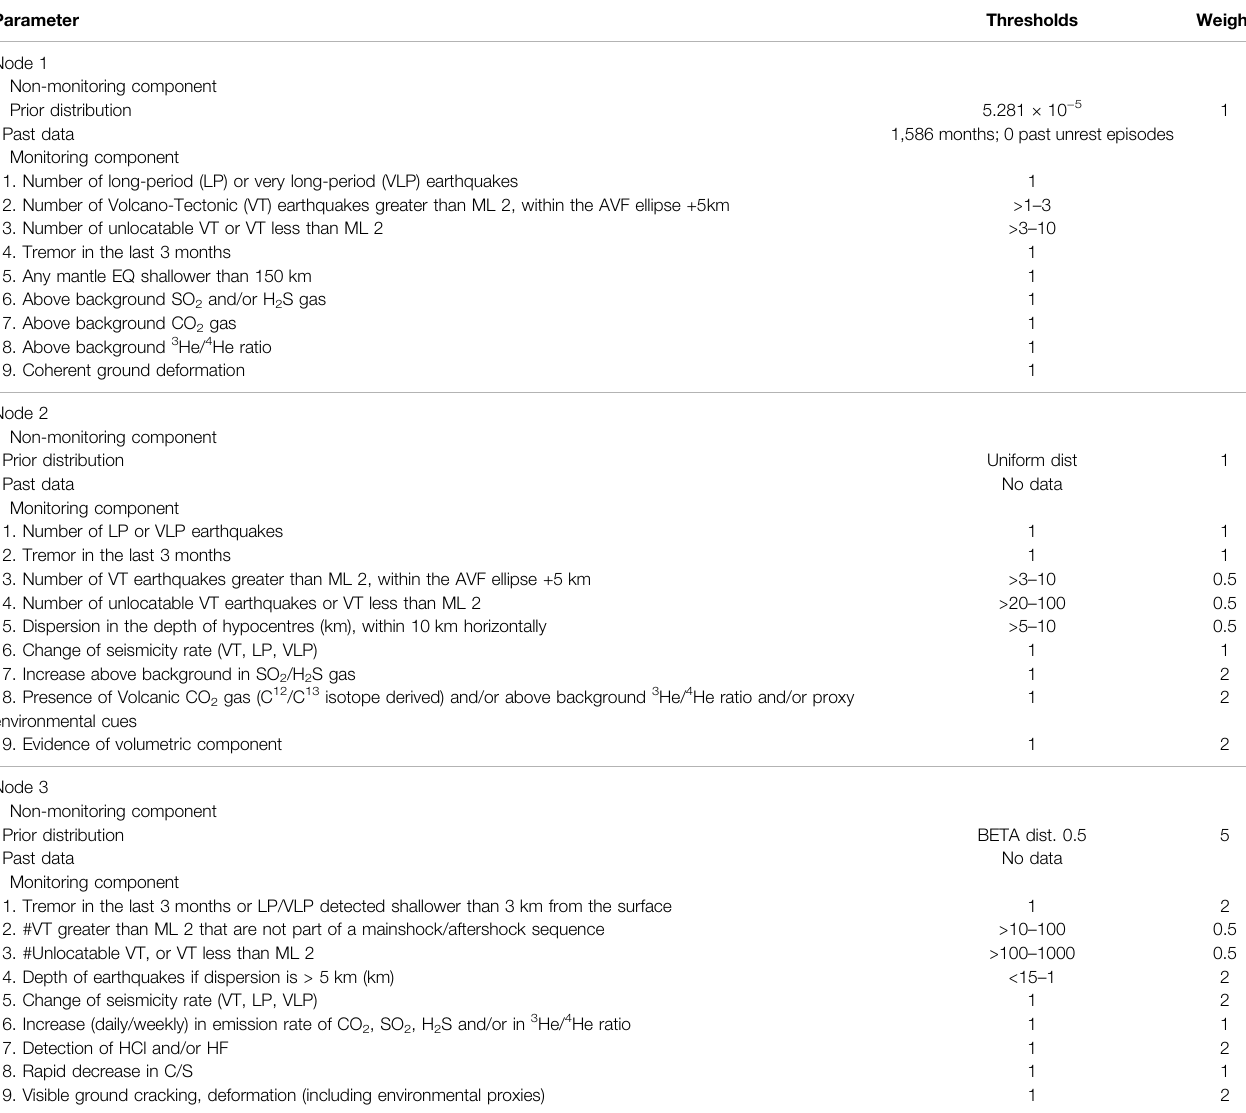
TABLE 1 | The volcanological and monitoring BETEF_AVF input data for each node. Refer to text for an explanation of parameters, thresholds and